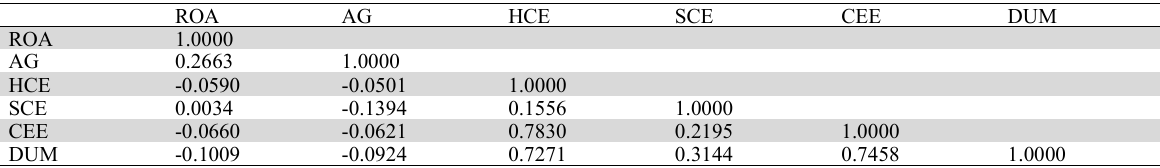
Correlation Coefficient between Variables